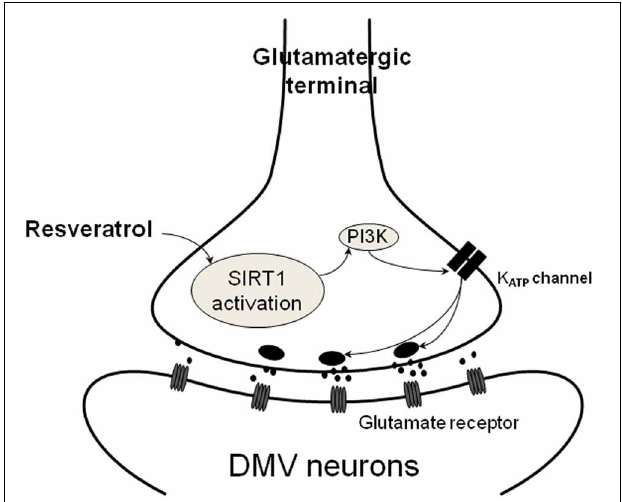
FIGURE 4 | Schematic illustration of resveratrol action on presynaptic terminals. SIRT1 activation with resveratrol results in increased glutamate release from presynaptic terminals. This mechanism depends on PI3-kinase dependent closure of K ATP channels leading to depolarization and increased neurotransmitter